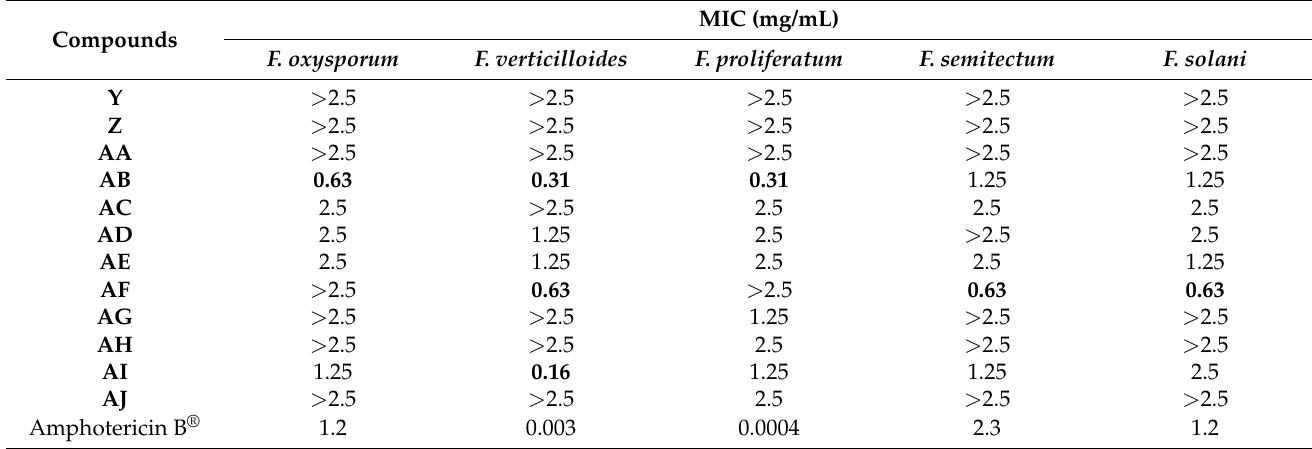
Table 5. Minimum inhibitory concentration (MIC) values of the compounds isolated from Withania somnifera leaf ethyl acetate extract investigated for antifungal activity against phytopathogenic fungi. MIC (mg/mL) Compounds F.